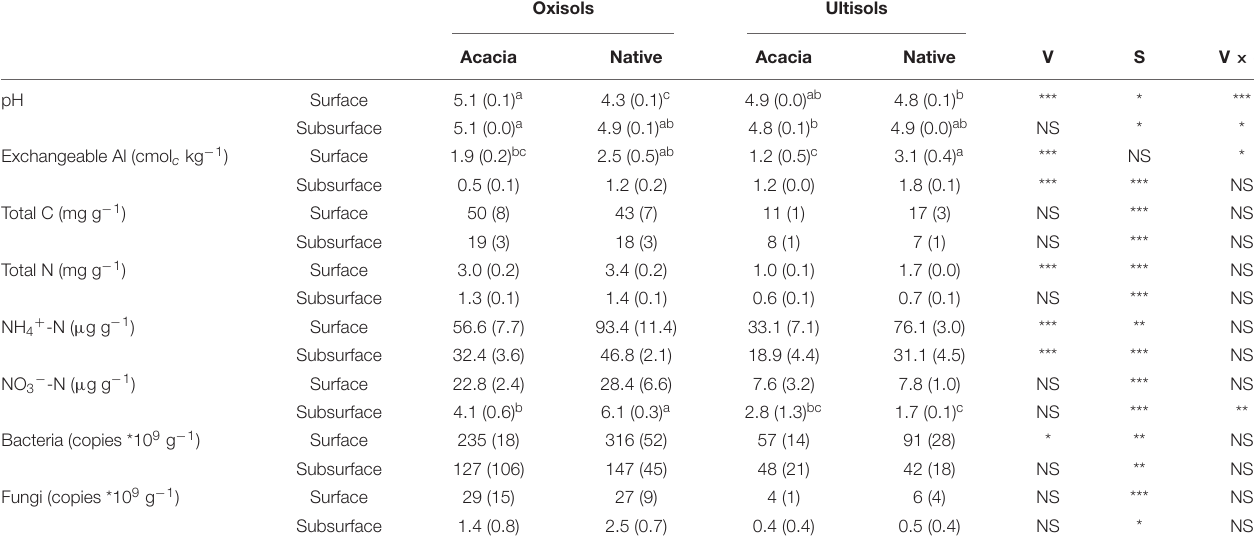
TABLE 1 | Soil biochemical properties in surface and subsurface horizons in two vegetations (Acacia and Native; V) for two soil types (Oxisols and Ultisols; S).